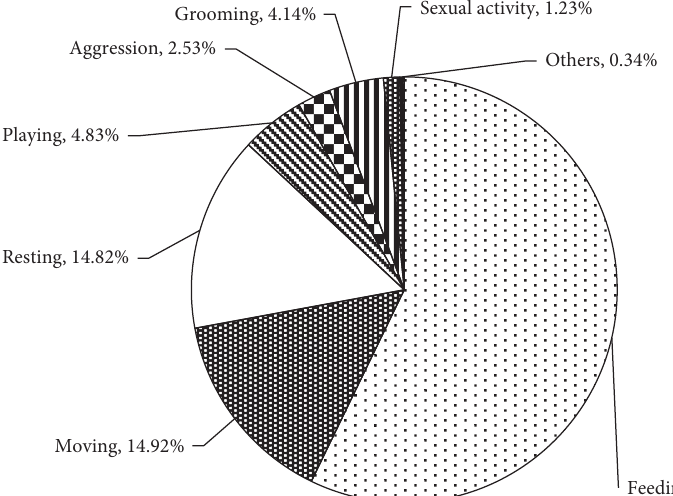
Figure 3: Overall activity time budget of geladas.